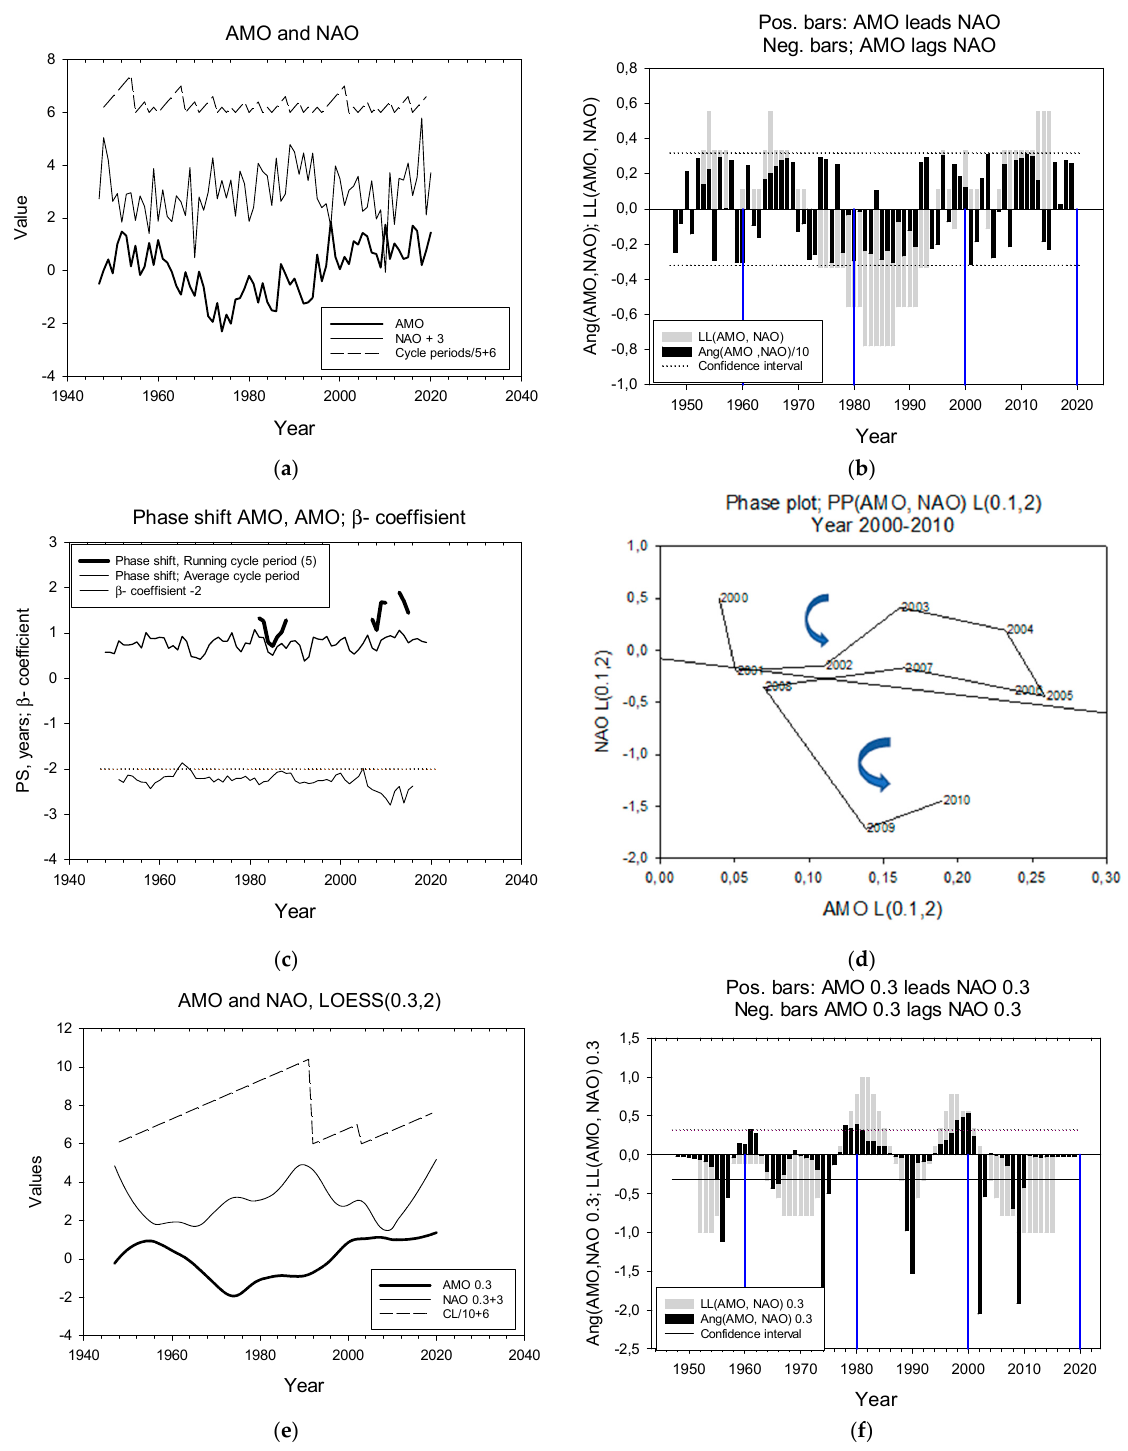
Figure 5. LL relations for AMO and NAO. ( a ) Time series raw. The upper zigzag curve shows cycle periods. ( b ) LL relations between AMO and NAO. Black bars show angles, θ (3), calculated over three consecutive observations; grey bars show the sign of angles, LL(9) calculated over 9 years. Dashed lines show confidence interval. Droplines designate time windows of 20 years starting at 1960. ( c ) Phase shift calculated with two methods (Thin line: average cycle period; bold line: running average cycle period) and the β -coefficient for the two series. ( d ) Phase plot for the two series with AMO and NAO slightly LOESS(0.1)-smoothed on the x- and y-axis, respectively. ( e ) The two series LOESS(0.3)-smoothed and their cycle periods. ( f ) LL relations between the two series. Black bars for θ (3), and grey bars for